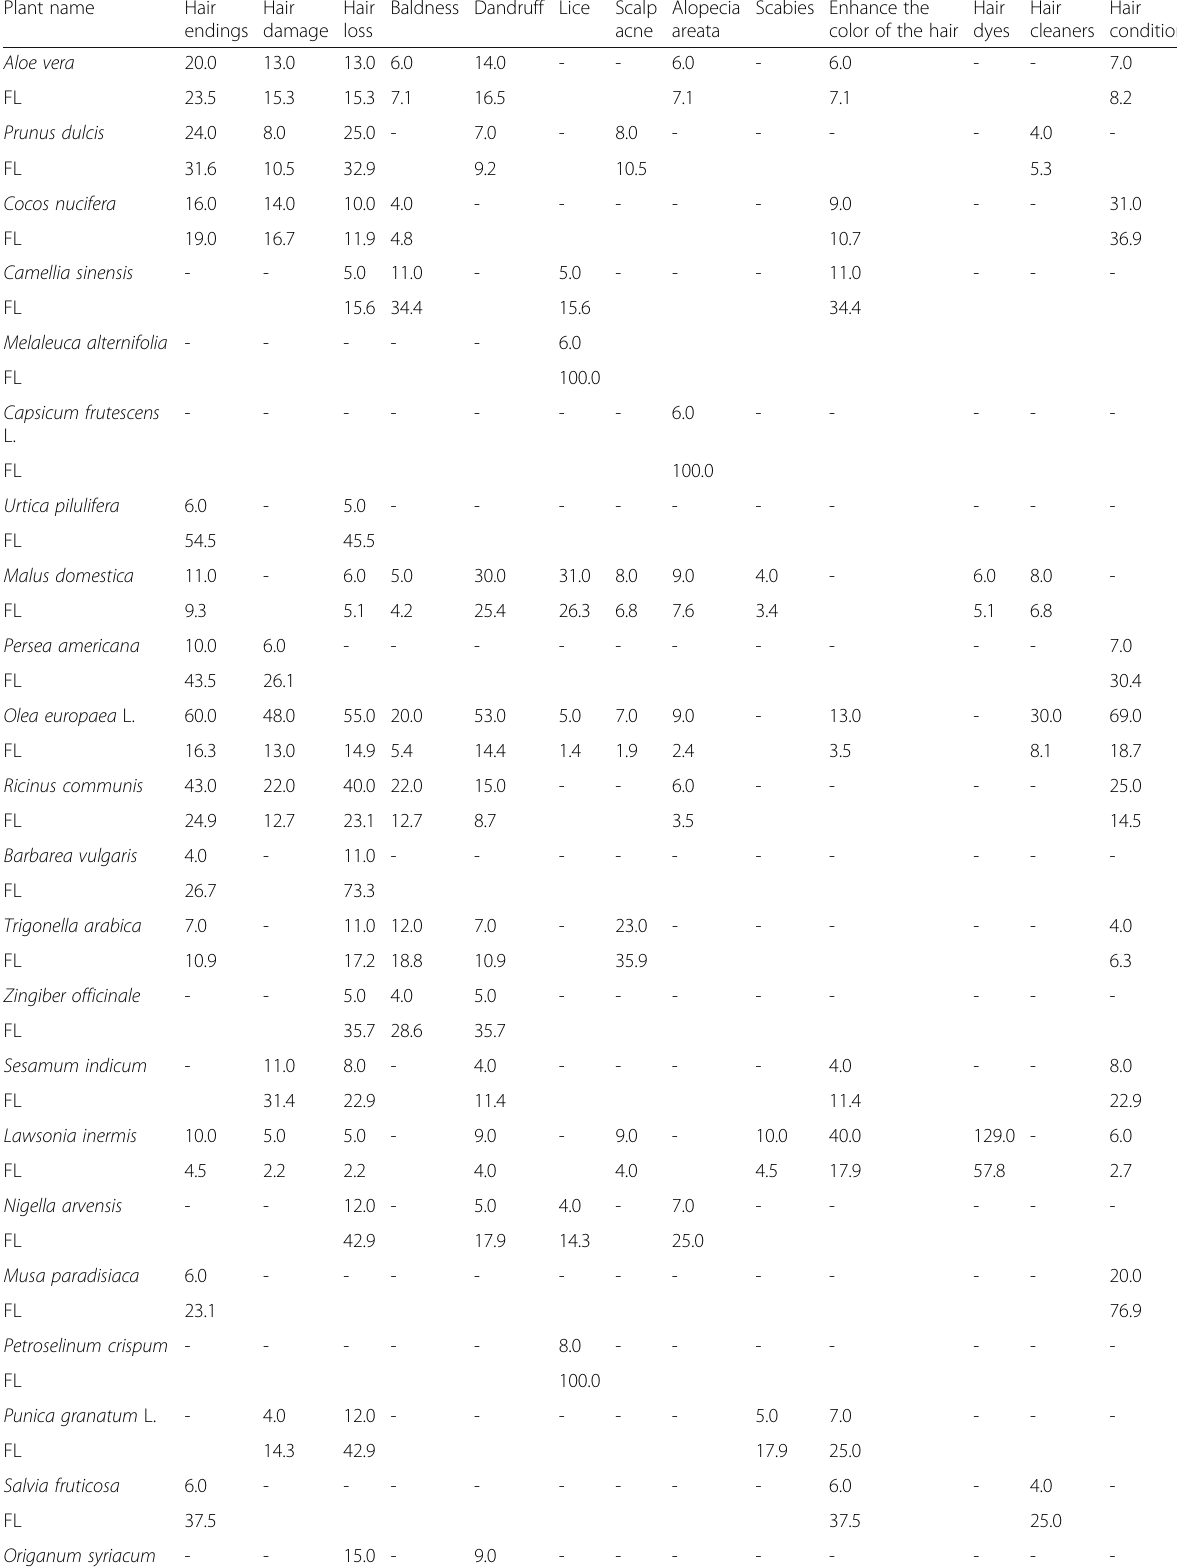
Table 3 Plants used as home remedies for treatment of hair and hair scalp in the West Bank/Palestine Plant